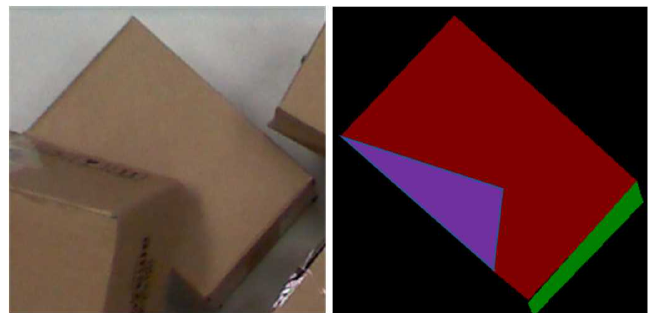
Figure 4. Schematic diagram of the pickable, unpickable, background and occlusion regions on a